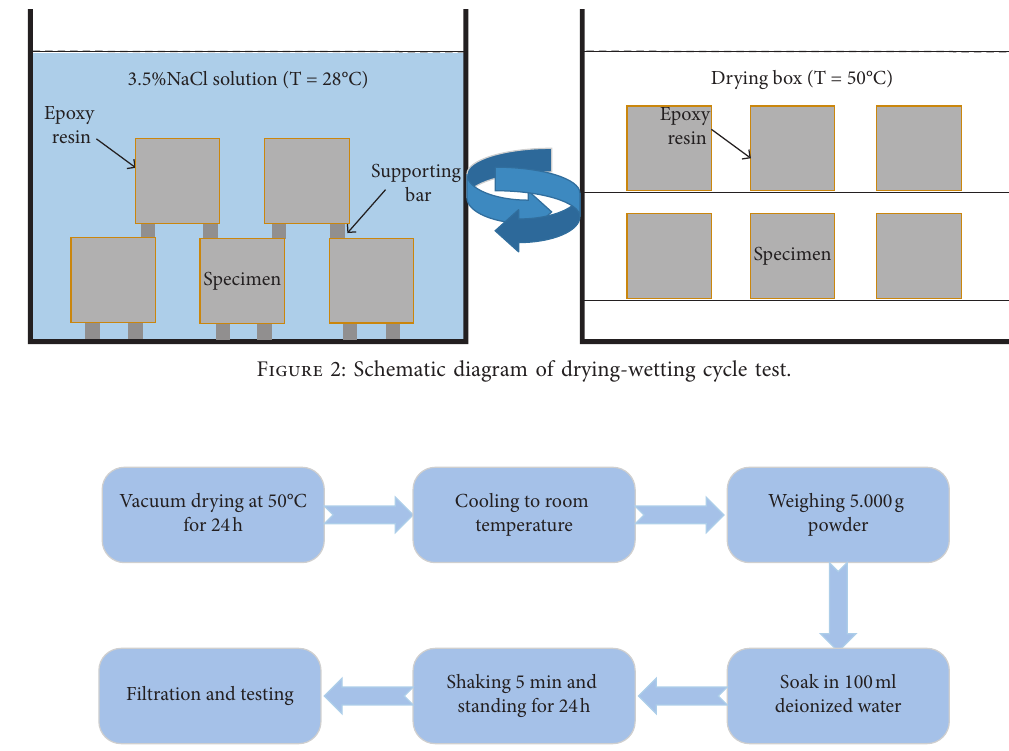
Figure 3: Testing process of pore solution pH and chloride concentration.